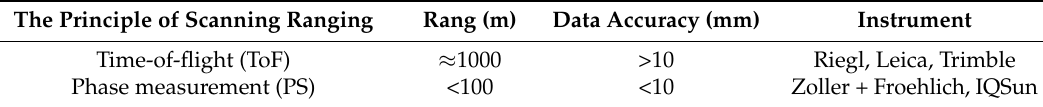
Table 1. The classification based on the different distance principle.